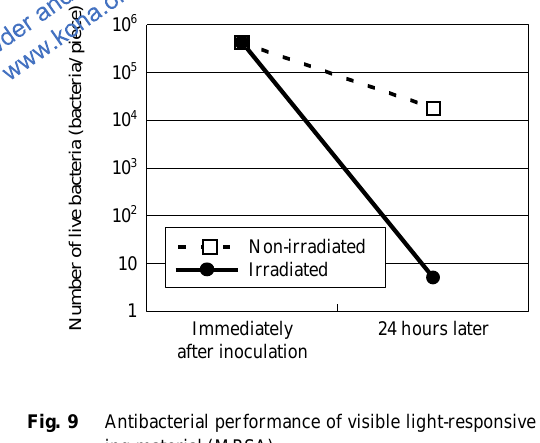
Fig. 9 Antibacterial performance of visible light-responsive coat- ing material (MRSA) Light irradiation: white fluorescent lamp, 1,000 lx Method: film contact method Executed by: Japan Food Research Laboratories